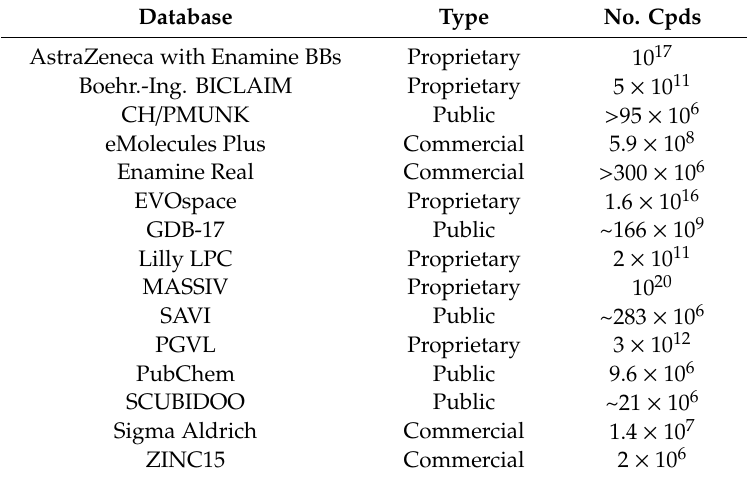
Table 3. Examples of public and commercial databases (data taken from